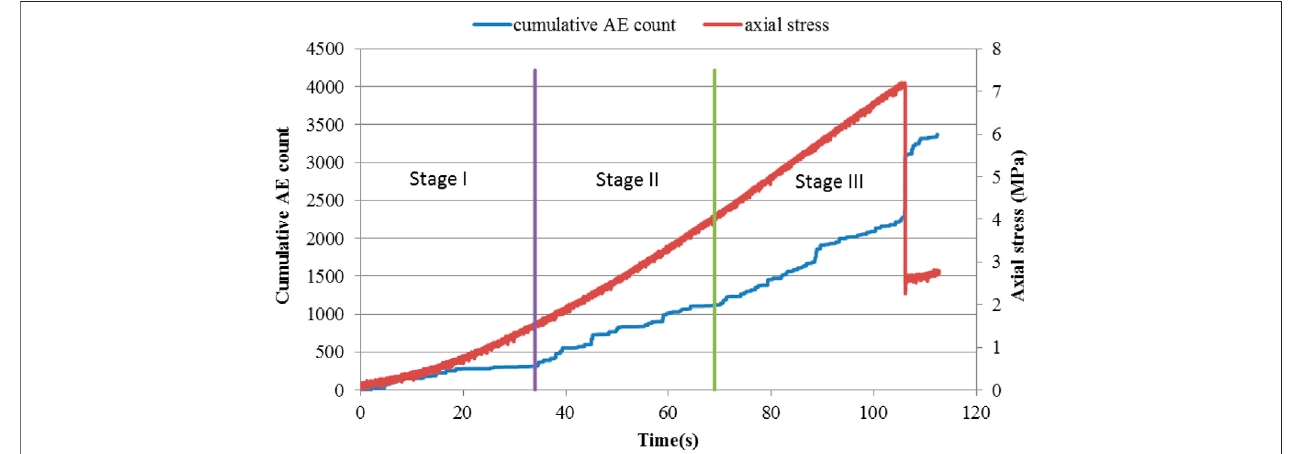
FIGURE 3 | Cumulative AE counts and axial stress versus loading time.